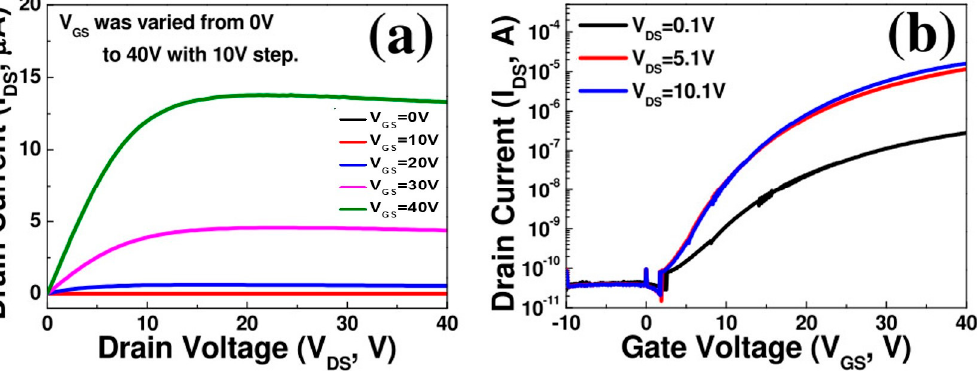
Figure 5. ( a ) Output characteristics and ( b ) transfer characteristics of the a-IGZO TFT thermal annealed at 300 ◦ C. The current-decreasing phenomena can be similarly observed.